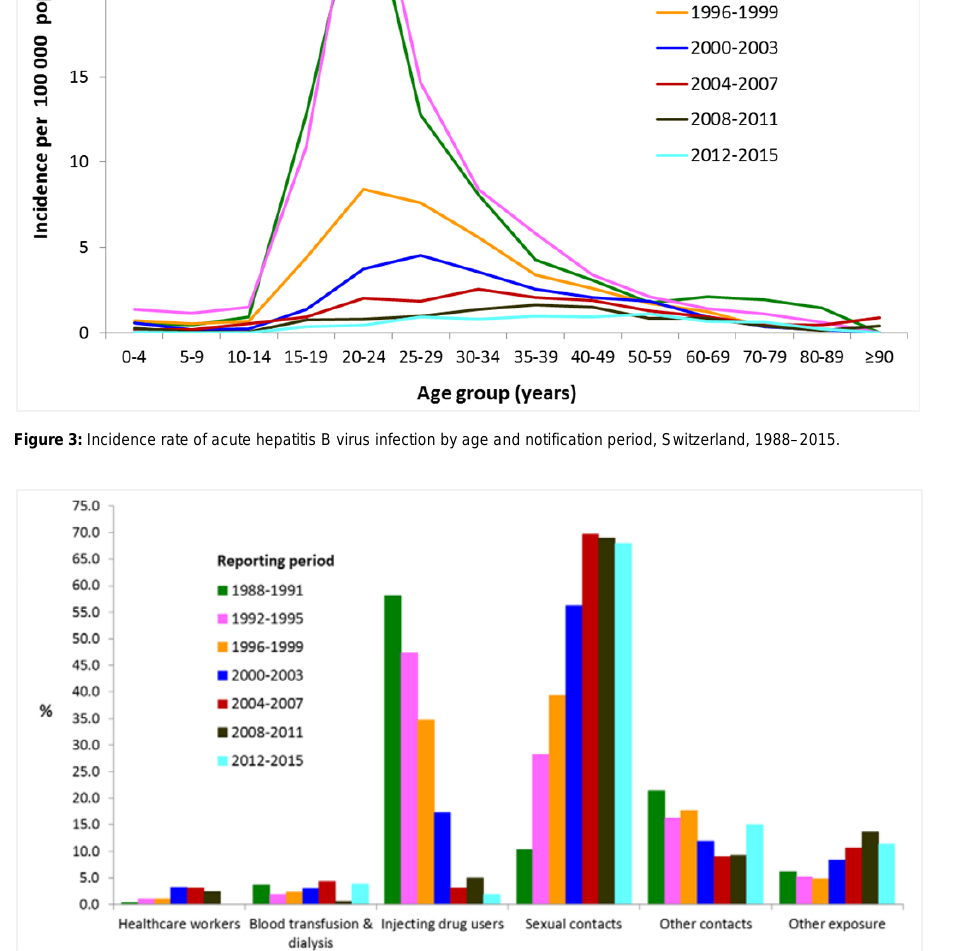
Chronic hepatitis B virus